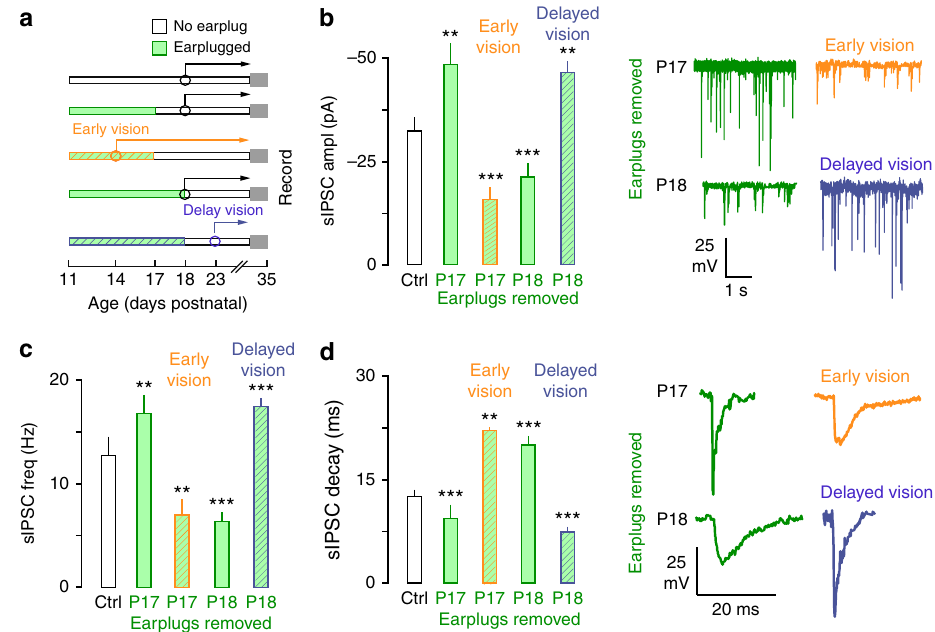
Table 3 | Visual experience regulates the IPSC CP of recovery from hearing loss.